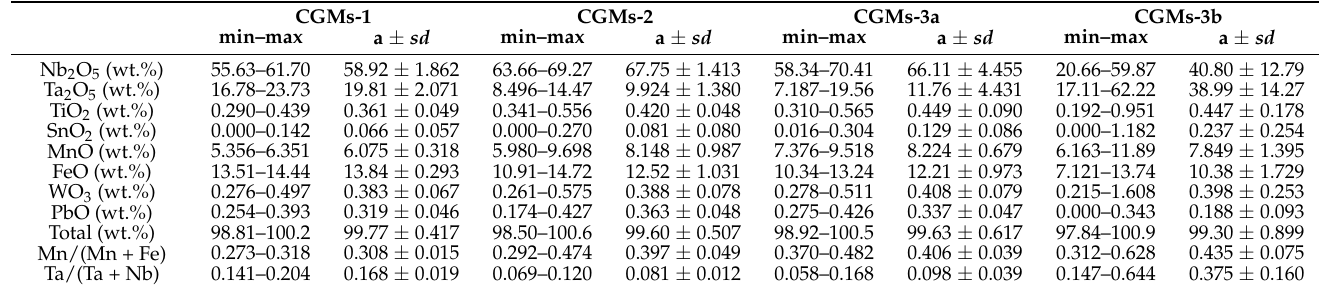
Table 1. Major-element compositional variations of the three-type CGMs in the spodumene pegmatite from the CKBS